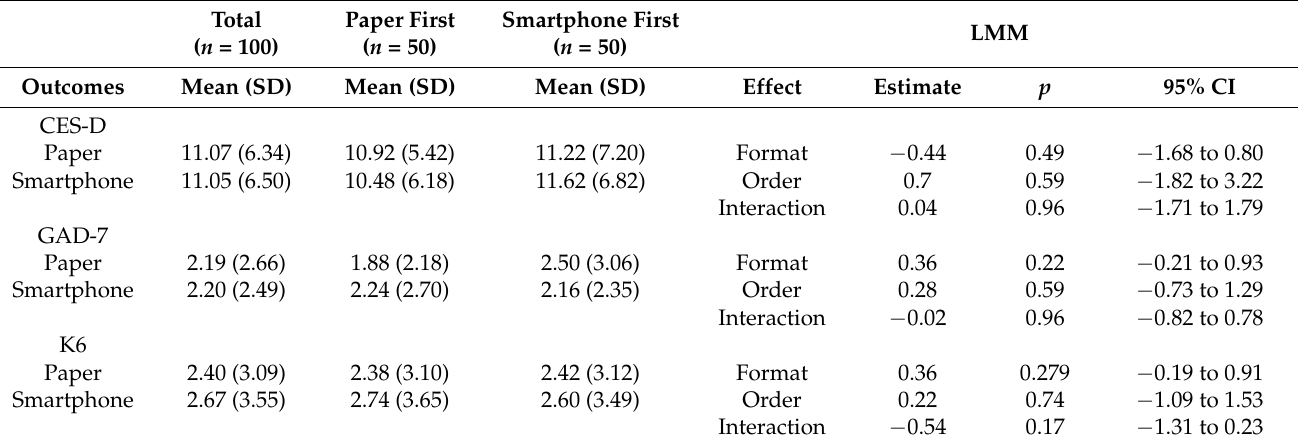
Table 2. Means (SD) and LMMs results.